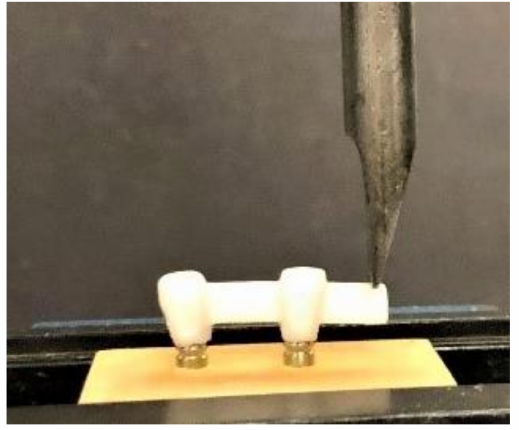
Figure 3. Loading on the specimen using an Instron testing machine.